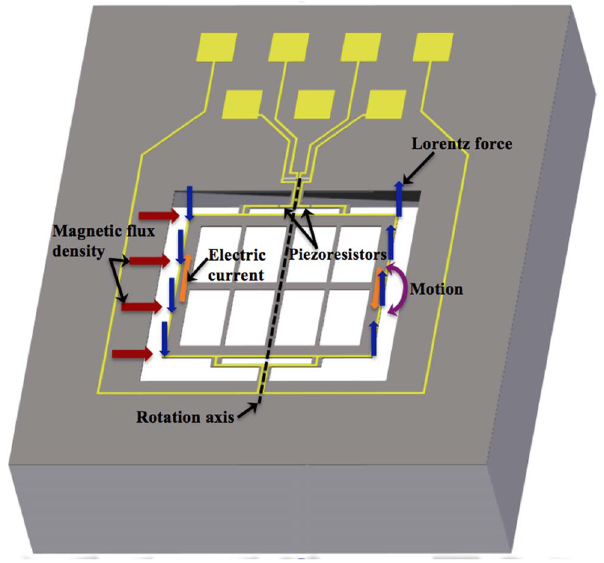
Figure 2. Schematic view of the operation principle of the MEMS magnetic field